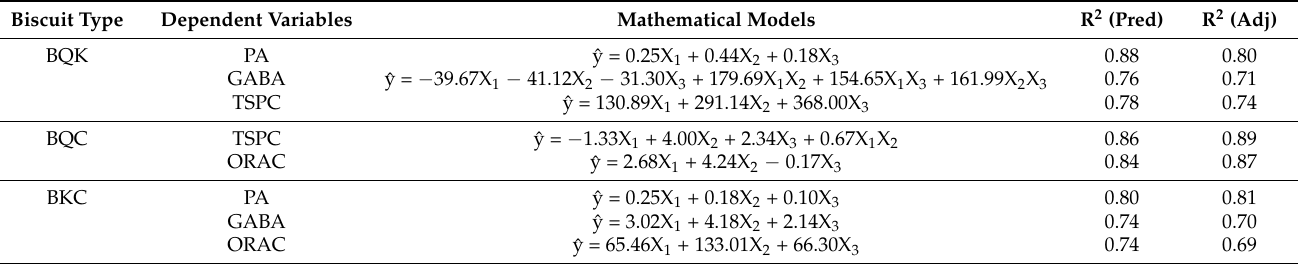
Table 3. Predictive regression models describing the relationships between the nutritional and bioactive attributes of the biscuit with a mixed composition of